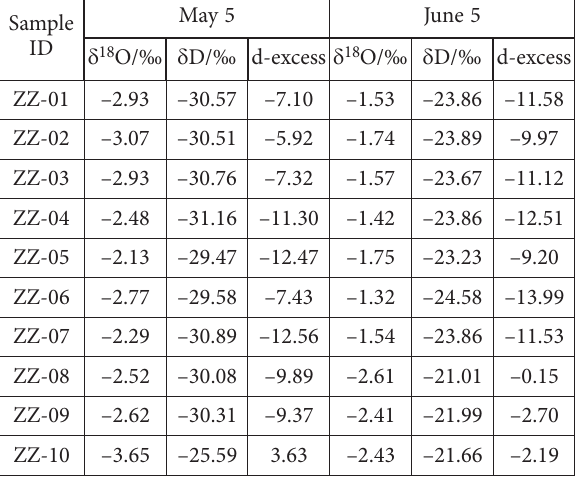
Table 1. Hydrogen and oxygen stable isotopic compositions